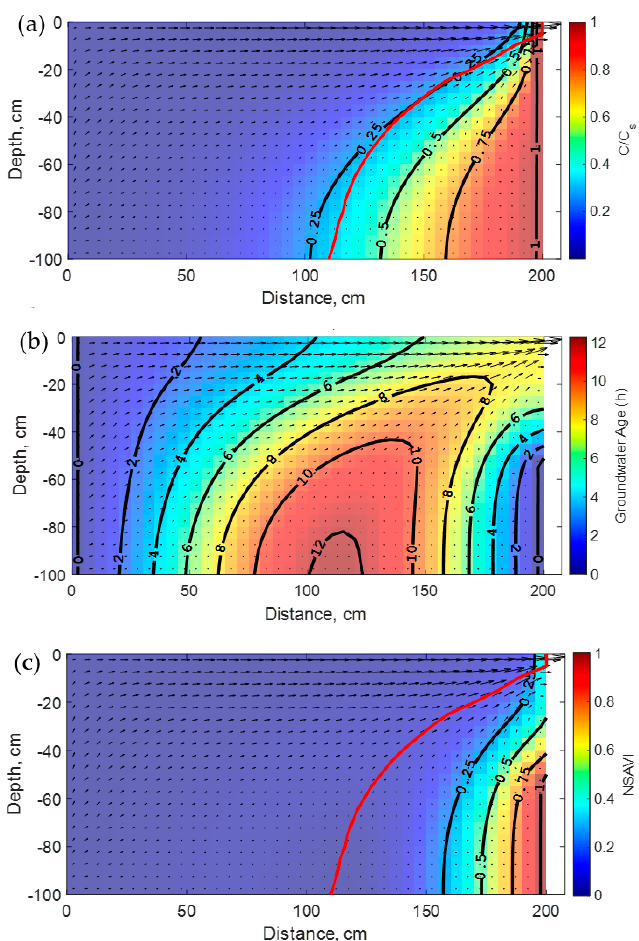
Figure 6. Spatial distribution patterns of ( a ) the steady-state concentration isochlors, ( b ) the direct mean groundwater age, and ( c ) the vulnerability index to seawater intrusion for the heterogeneous Henry problems with an exponentially decaying permeability with depth ( δ = 3 ). The zero-vulnerability line (ZVL) is plotted with red color.